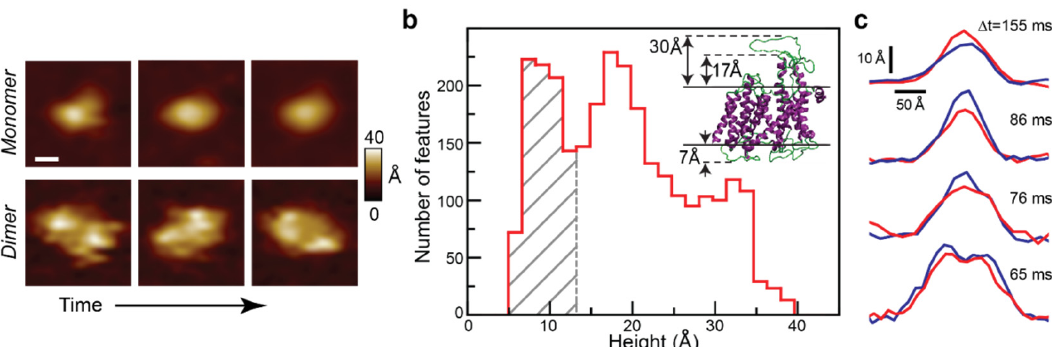
Figure 1. Membrane-external cytoplasmic protrusion dynamics of translocon SecYEG. ( a ) Successive AFM images of monomeric and dimeric features are displayed. The scale bar is 50 Å and applies to all images. The elapsed time between image frames was 180 s. ( b ) Histogram of the maximum height of individual SecYEG features ( N = 2766, bin size = 1.7 Å). Grey hatched region represents periplasmic SecYEG with one major peak (~7 Å). In contrast, the cytoplasmic side of SecYEG exhibited two peaks (~17 Å and ~32 Å), with a substantial population of features with heights in between. ( b , inset): crystal structure (PDB code: 3DIN) of SecYEG indicating asymmetry. The maximum height of the periplasmic protrusion is ~7 Å. In contrast, it is ~30 Å on the cytoplasmic side. The ends of the 8–9 helices extend ~17 Å above the lipid bilayer. Membrane boundaries are indicated (solid black lines). ( c ) Pairs of individual line scans are displayed (Red: trace; blue: retrace). The time difference between trace and retrace is shown for each pair of profiles. Data adapted from Ref. [16].